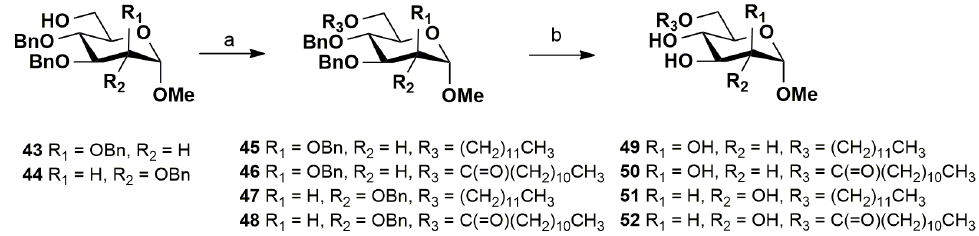
Figure 2. The reference compounds.